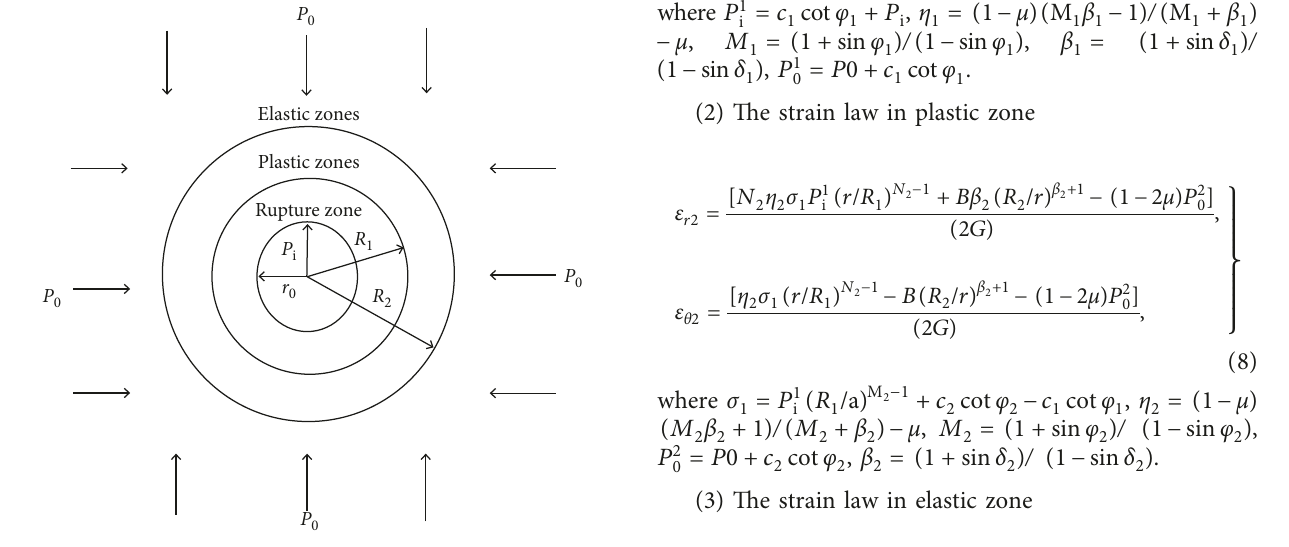
Figure 8: Analytic model of a circular